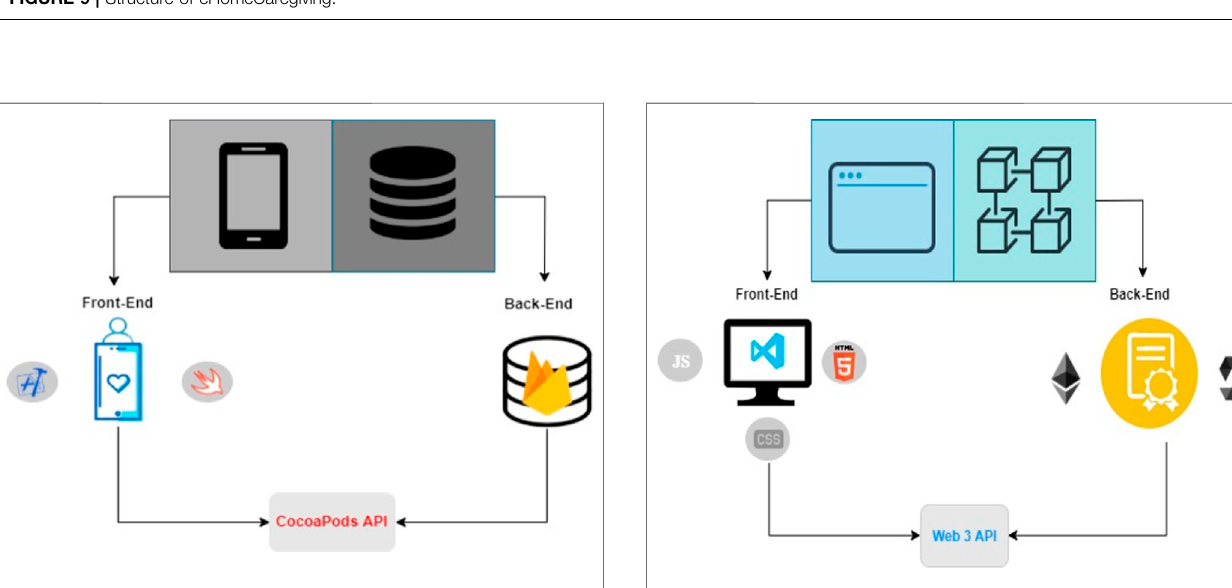
FIGURE 9 | Structure of eHomeCaregiving.